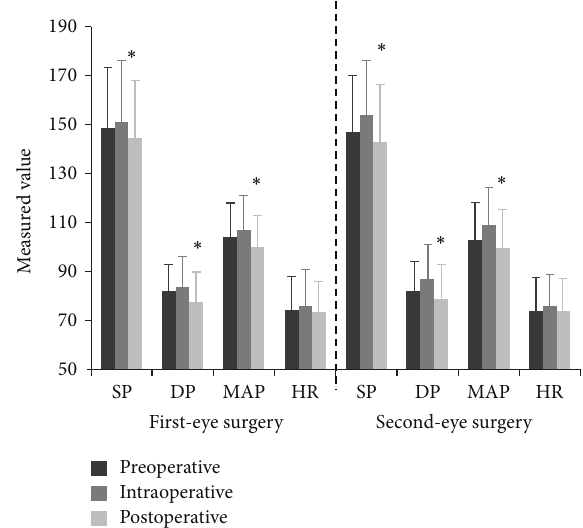
Figure 1: Comparison of blood pressure and heart rate among cataract patients who underwent first-eye or second-eye surgery. SP, systolic pressure; DP, diastolic pressure; MAP, mean arterial pressure; HR, heart rate. ∗ Systolic blood pressure, diastolic blood pressure, and mean arterial pressure were significantly different betweenthepostoperativeandintraoperativemeasurements(all 𝑃 < 0.05 ; one-way analysis of variance, followed by the least significant difference